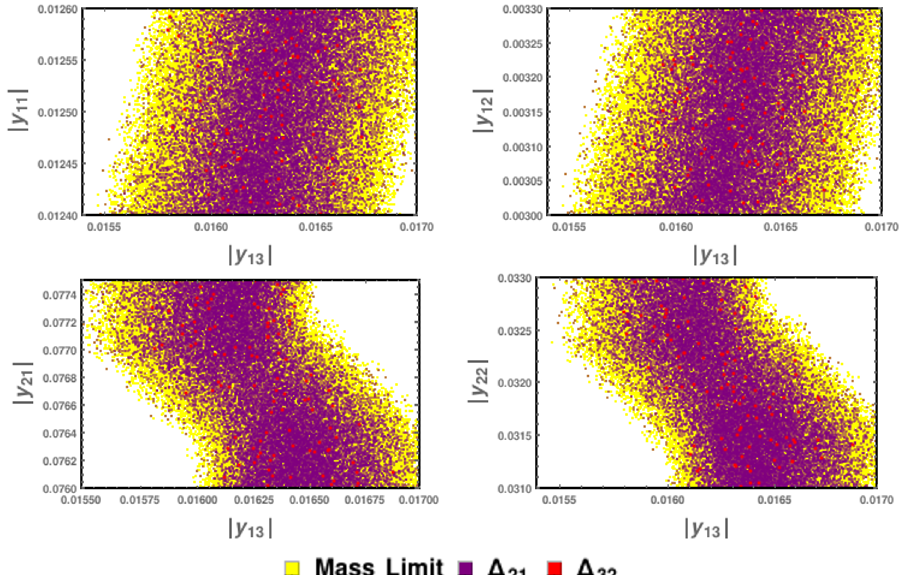
Figure 1. Correlation of Yukawa couplings in the Dirac sector for neutrino masses in normal hierarchy. Allowed points after diagonalization of neutrino mass matrix satisfying the bound on total mass of three neutrino species (in yellow), points with satisfying the bound on (cid:1) m 2 purple) and allowed points after another bound of (cid:1) m 2